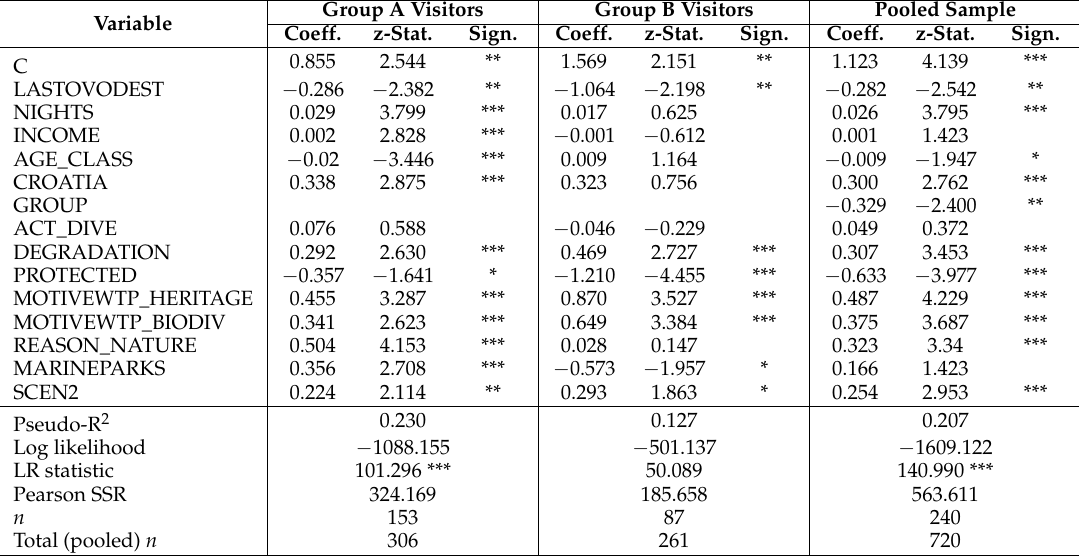
Table 6. Econometric results: Determinants of willingness-to-pay for the improvement of marine biodiversity of visitors to Lastovo